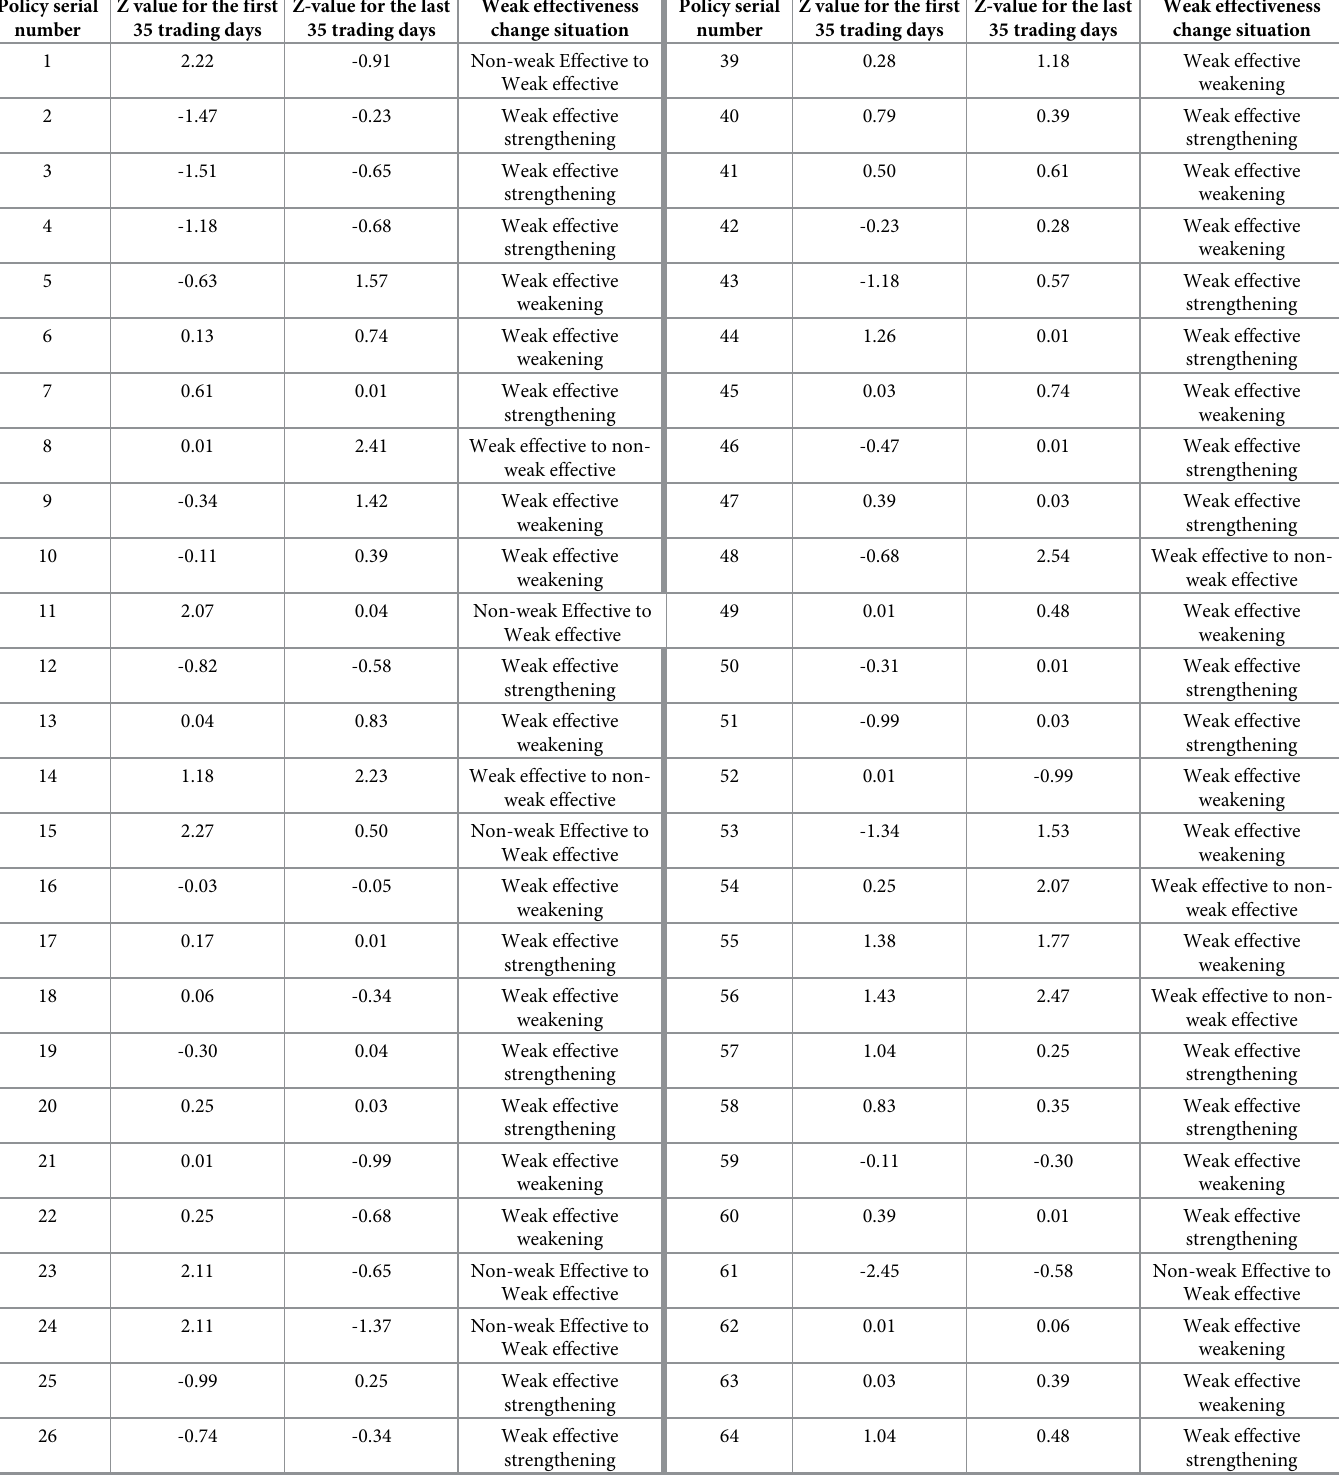
Table 2. Macro-policy information and weak efficiency